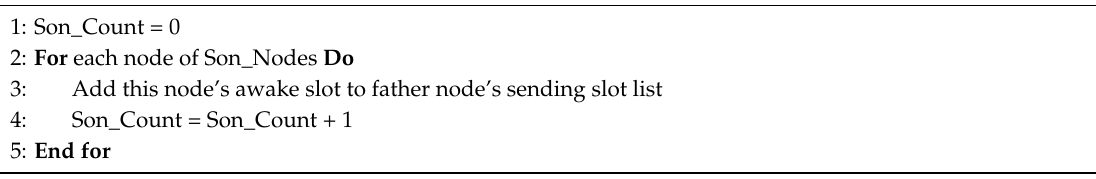
Algorithm 1 Initialize father node under IFAS scheme